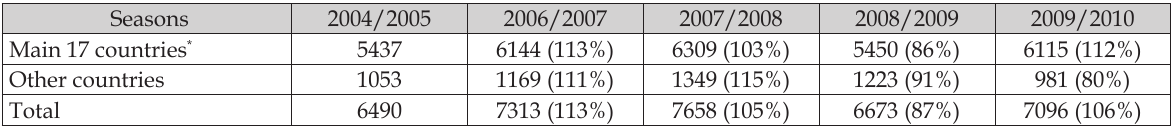
Table 1. Total number of tourists visiting Aconcagua region in particular tourist